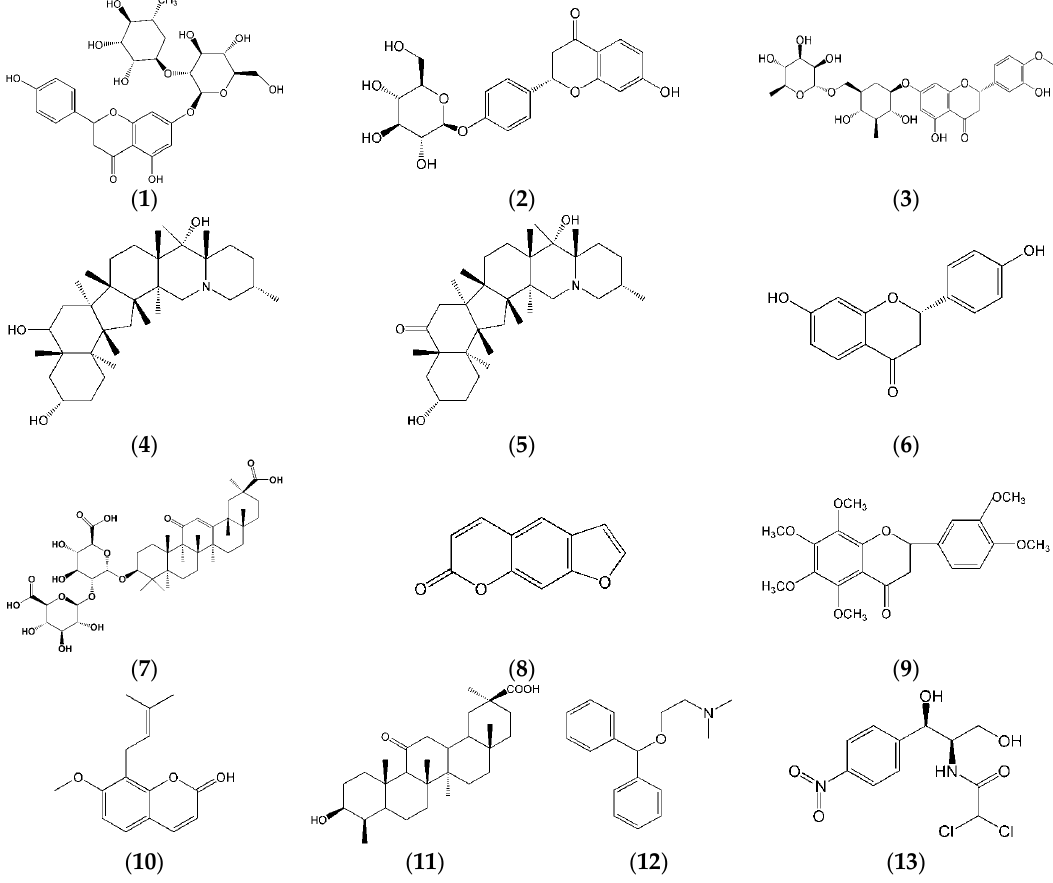
Figure 1. The chemical structures of liquiritin ( 1 ); naringin ( 2 ); hesperidin ( 3 ); peimine ( 4 ); peiminine ( 5 ); liquiritigenin ( 6 ); glycyrrhizic acid ( 7 ); bergapten ( 8 ); nobiletin ( 9 ); osthole ( 10 ); glycyrrhetinic acid ( 11 ); diphenhydramine (IS for positive ionization mode) ( 12 ); and chloromycetin (IS for negative ionization mode) ( 13 ).